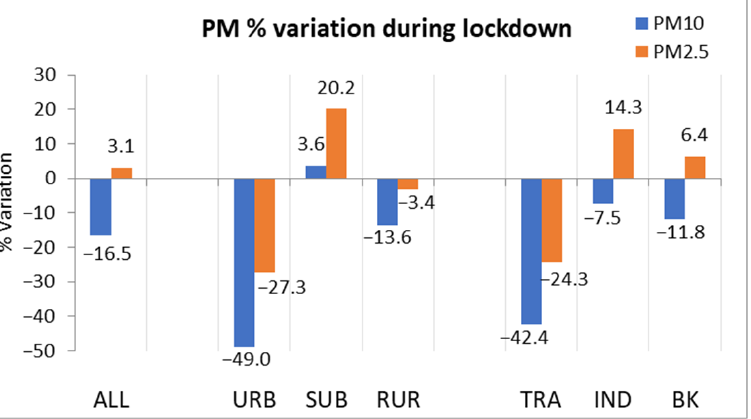
Figure 3. Variation of PM for all the stations and stations grouped according to different charac-